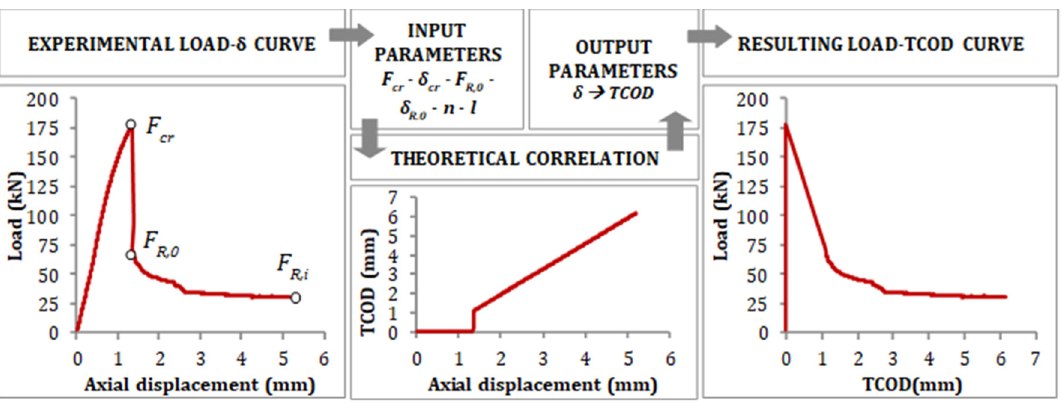
Figure 10 . Correlation between axial displacement and TCOD. Table 4. Statistical parameters that influence the pouring procedure’s influence on the fibre amount